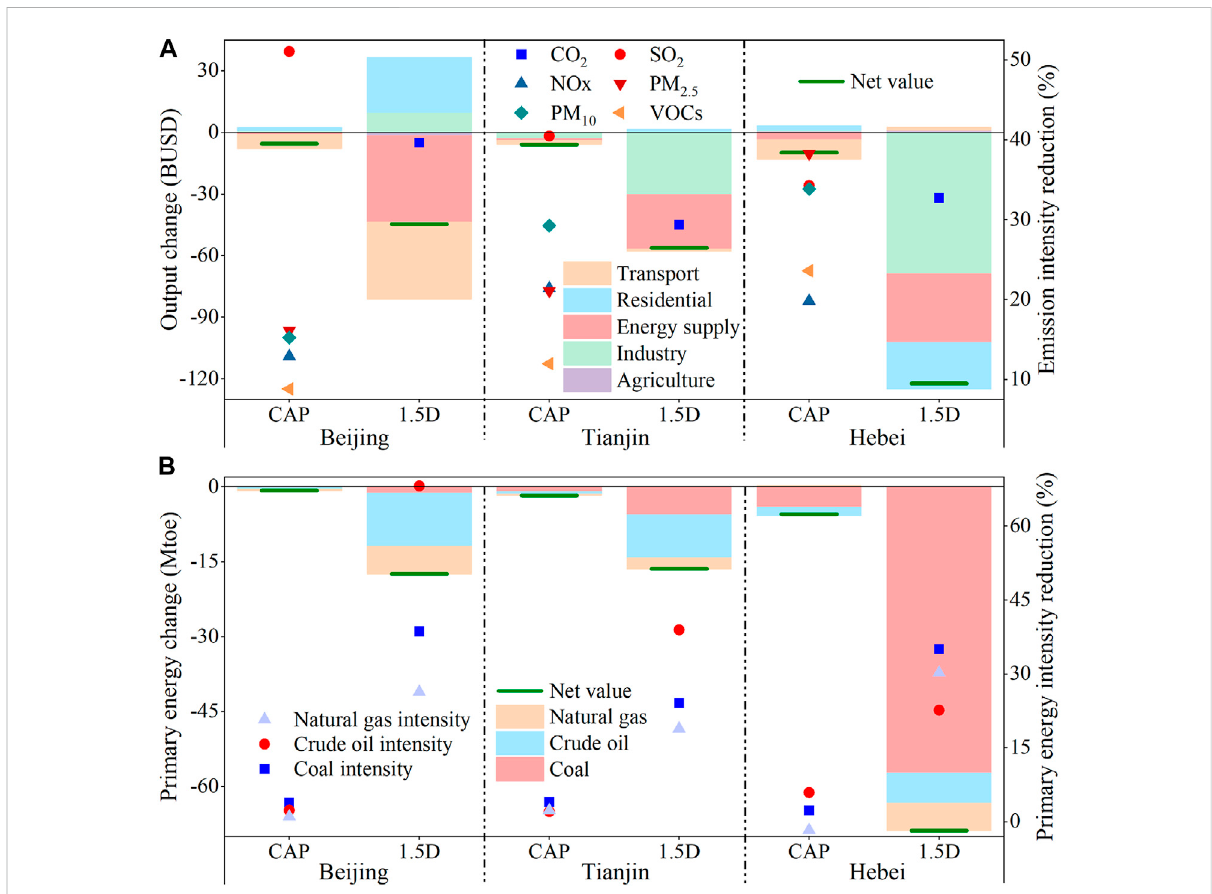
FIGURE 4 Output change and emission intensity change in Beijing, Tianjin and Hebei in different sectors of CAP and 1.5D scenarios comparedwith REF in 2030 (A) , primary energy change and energy intensity reduction in Beijing, Tianjin and Hebei of different energy types in CAP and 1.5D scenarios compared with REF in 2030 (B) . The change of air pollutants emission intensity and the 1.5D scenario shows the CO 2 emission intensity